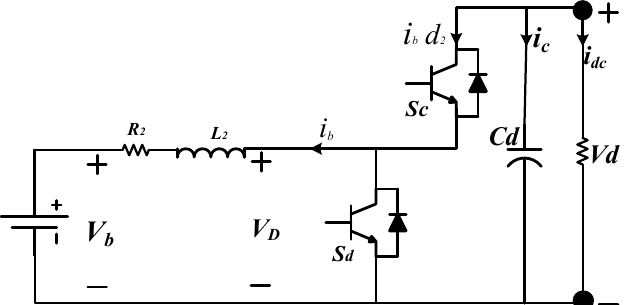
Figure 6. Configuration of the DC-to-DC converter interface with the electric vehicles (EVs) battery and the DC bus.